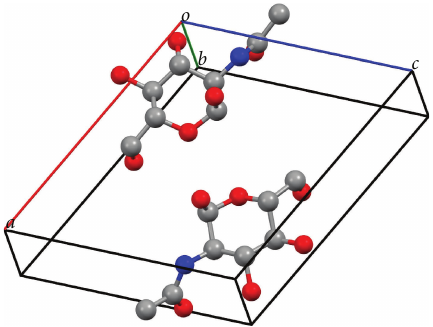
Figure 1: Crystal cell of N